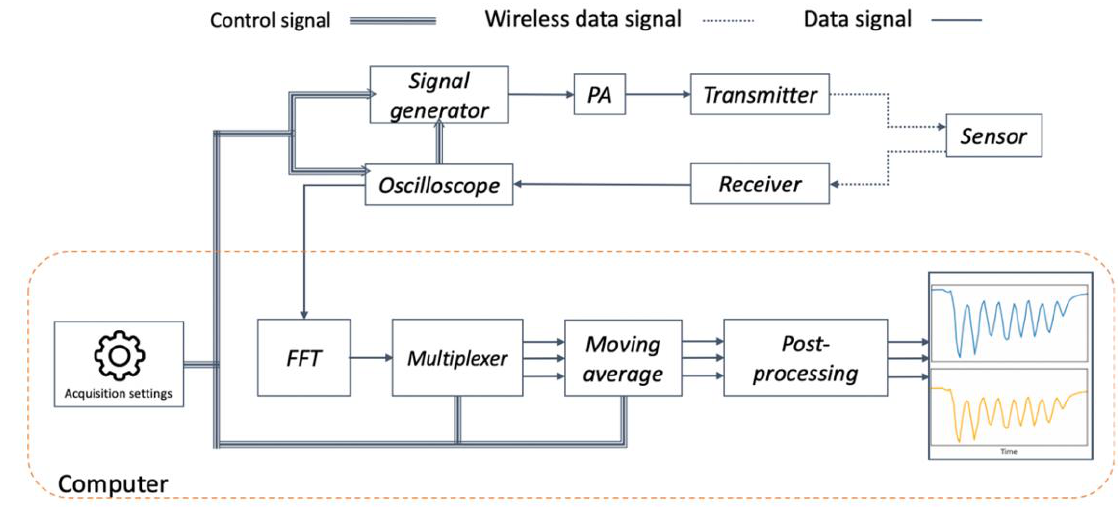
Figure 8. Signal acquisition flow chart highlighting the major components/stages of the respiratory sensing system. The Power Amplifier (PA) component is strictly optional. Here, the profile derived from the reference MEMS is not displayed in the output.